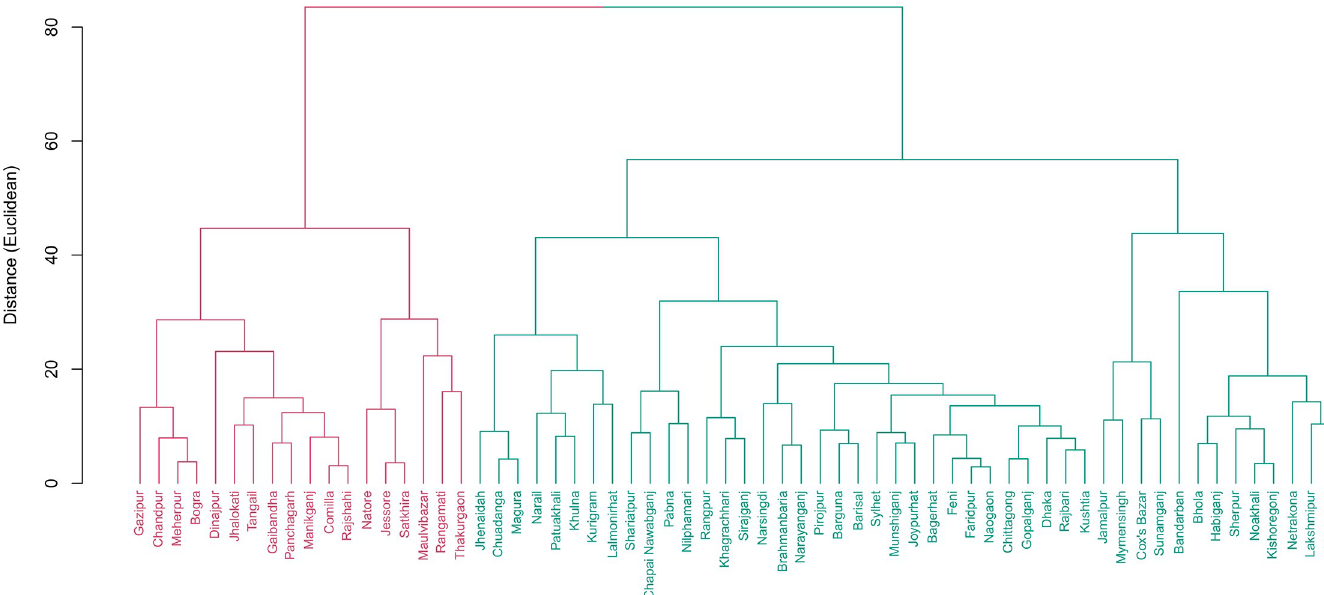
Fig 2. Cluster of districts based on educational indicators. Two clusters were found. Cluster 1 include 18 districts while 46 districts were in cluster 2. Districts in cluster 1 are performing below national level whereas those in cluster 2 are above national level.